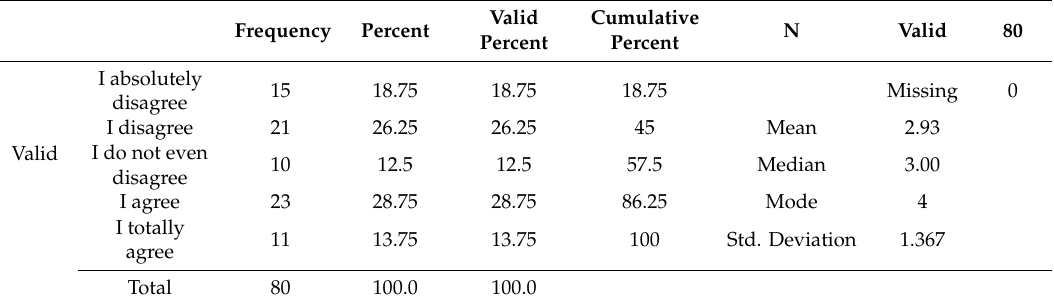
Table 2. Teacher’s support in relation to student